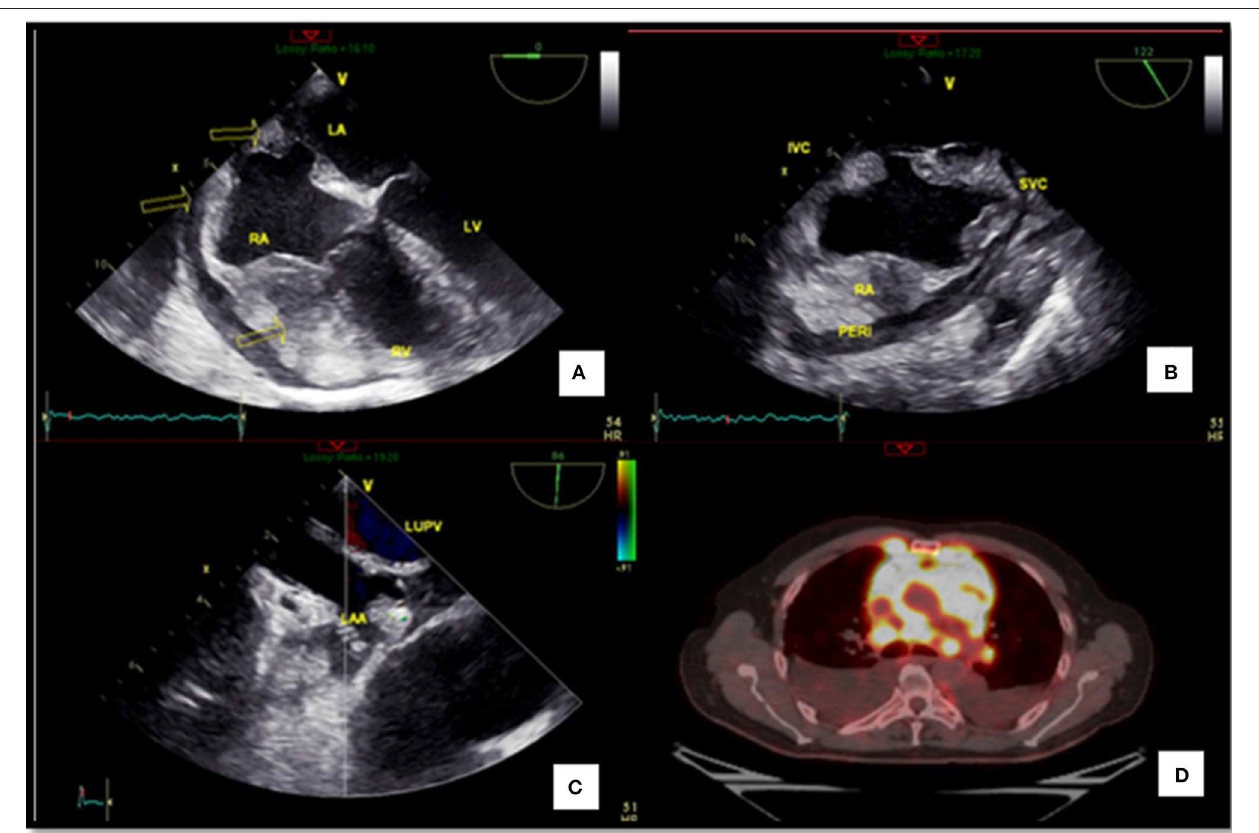
FIGURE 1 | Extension of the lymphoma . (A) Transesophageal echocardiography revealing right ventricular infiltration. (B) Transesophageal echocardiography bicaval view showing an infiltration of the right atrium. (C) Transesophageal echocardiography (left atrial appendage with a dense round image that could be a thrombus). (D) PET-CT revealing the extension of the lymphoma. RA, Right atrium; RV, Right ventricle; LA, Left atrium; LUPV, Left upper pulmonary veins; LAA, Left atrial appendage; IVC, Inferior vena cava; SVC, Superior vena cava; PERI,